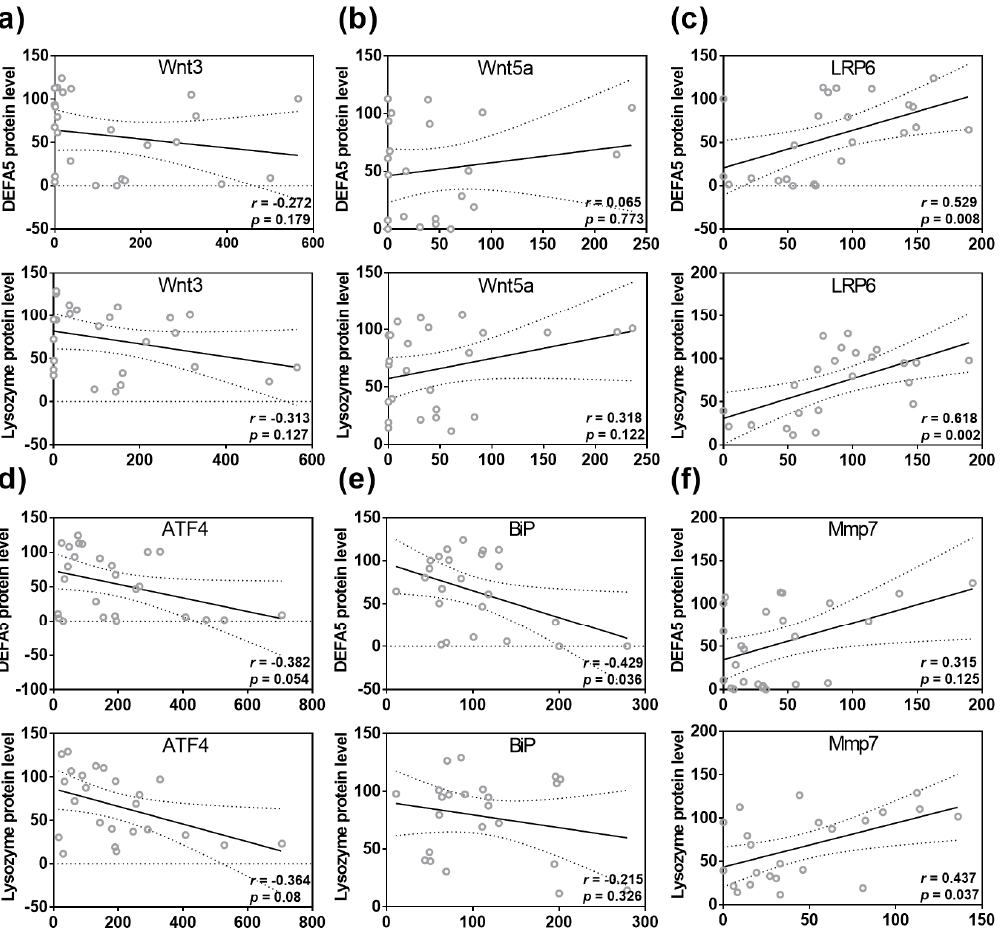
Figure 4. Disturbances in Wnt, ER stress and Mmp7 are correlated with reduced DEFA5 and lysozyme protein levels in the small intestine. Correlation analysis for DEFA5 or lysozyme protein level and Wnt3 ( a ), Wnt5a ( b ), LRP6 ( c ), ATF4 ( d ), BiP ( e ), Mmp7 ( f ) expression. Statistical analysis was performed by two-tailed Spearman rank correlation analysis. Correlations in the range of 0.3 to 0.6 or − 0.3 to − 0.6 were de fi ned as positive or negative correlations. For abbreviations, see Figures 1–3.